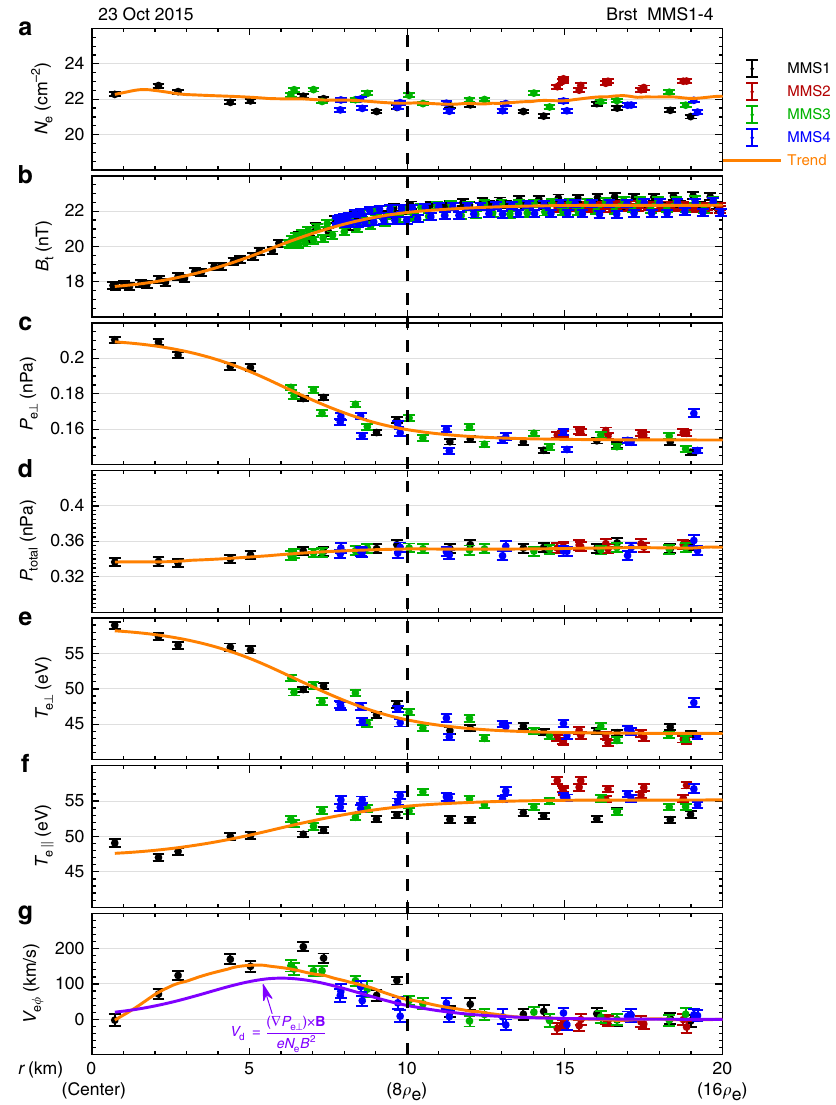
Fig. 5 Radial distributions of the electron plasma parameters and the magnetic fi elds. Panels a – g show electron number density ( N e ), magnetic fi eld strength ( B t ), perpendicular pressure ( P e ⊥ ), total pressure ( P total ), perpendicular temperature ( T e ⊥ ), parallel temperature ( T e|| ), and electron tangential bulk velocity ( V e ϕ ). The x -axis is the distance ( r ) between the measuring position and the center of the ESMC. In each panel, solid dots with error bars represent direct observations, and the spacecraft are labeled as different colors. The orange curves represent a trend of the collective. In panel g , the purple curve is a diamagnetic drift velocity ( V d ) estimated from P e ⊥ . The dashed line marks the radius of the ESMC (i.e., R MC ) obtained by the sounding technique. The error bars are instrumental errors directly obtained from the FPI data product except for P total , which is derived from its de fi nition and the propagation of Fig. 1 that the proton scale magnetic fi eld depression is balanced by proton pressure.